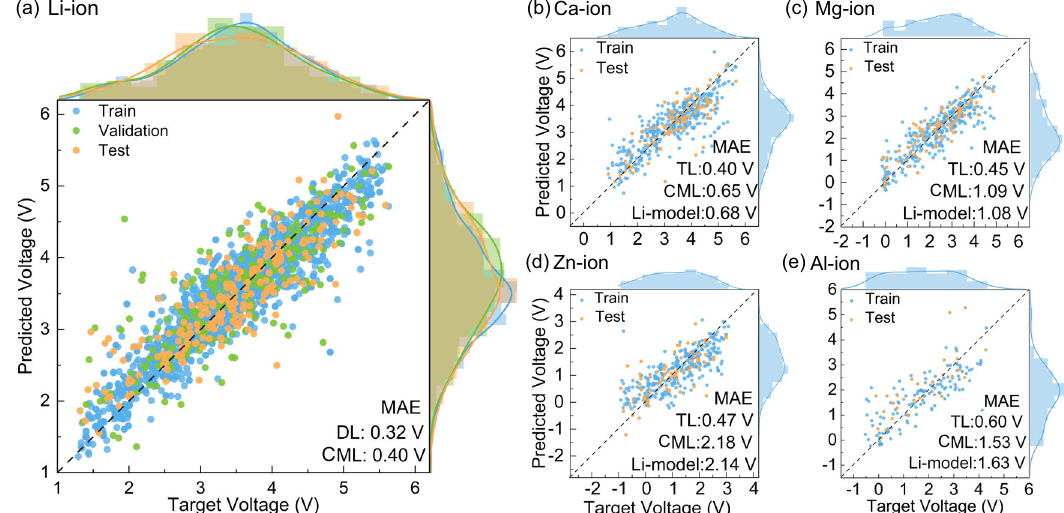
Fig. 2 Plots of predicted voltage and target voltage for the metal-ion batteries. a The data points are predicted with the deep-learning model and those in b – e are predicted with the transfer-learning model. The model errors of the Li-, Ca-, Mg-, Zn-, and Al-ion battery are shown in the right-down corner. The histograms at the top and right show the distributions of predicted and target voltages, respectively. The black dashed line is the identity line ( y = x ) for reference. The TL, CML, and Li-model mean the transfer learning, conventional machine learning, and the model trained on LIB database only.